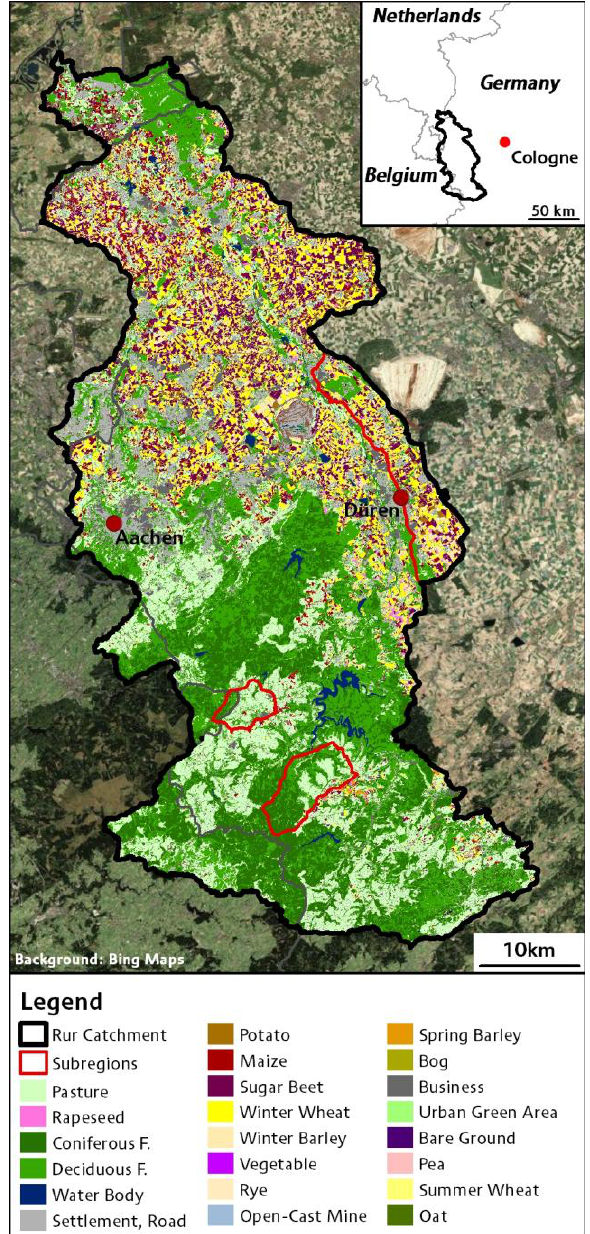
Figure 1. LU Classification of 2008 for the CRC/TR32 study area, the Rur Catchment